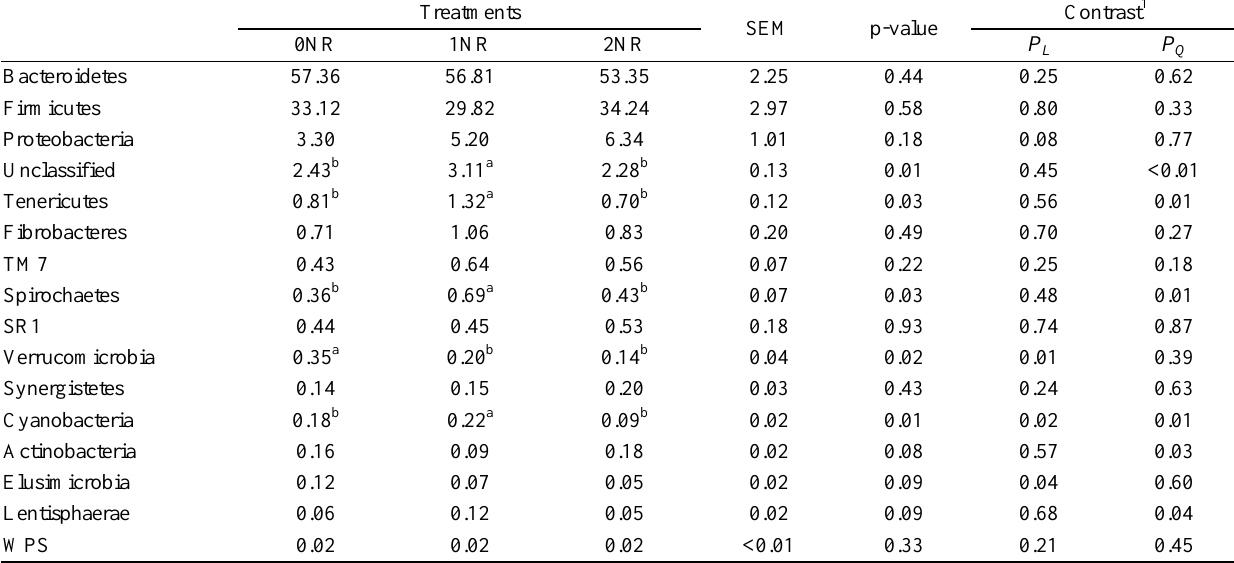
Table 2. Effects of nitrate on the relative abundance of bacterial phyla (% of total sequences) using NGS technology Treatments SEM p-value